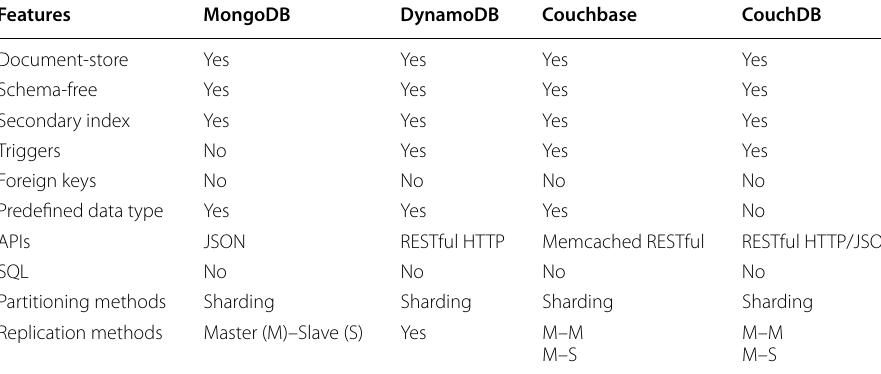
Table 2 Features of document-model databases